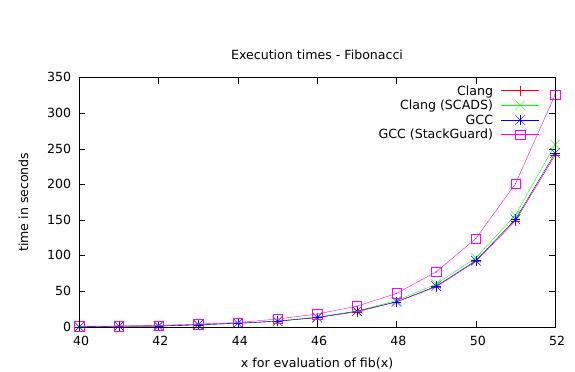
Figure 13. Execution times of the program defined by listing